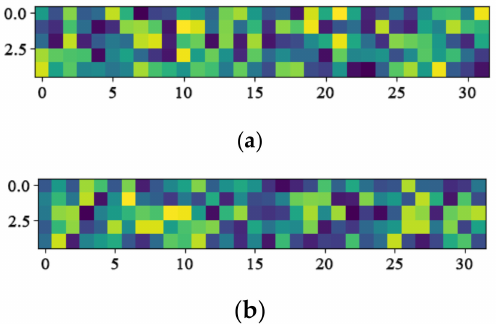
Figure 14. The visualization of convolution kernels in the second convolutional layer. ( a ) Kernel 1 ( b ) Kernel